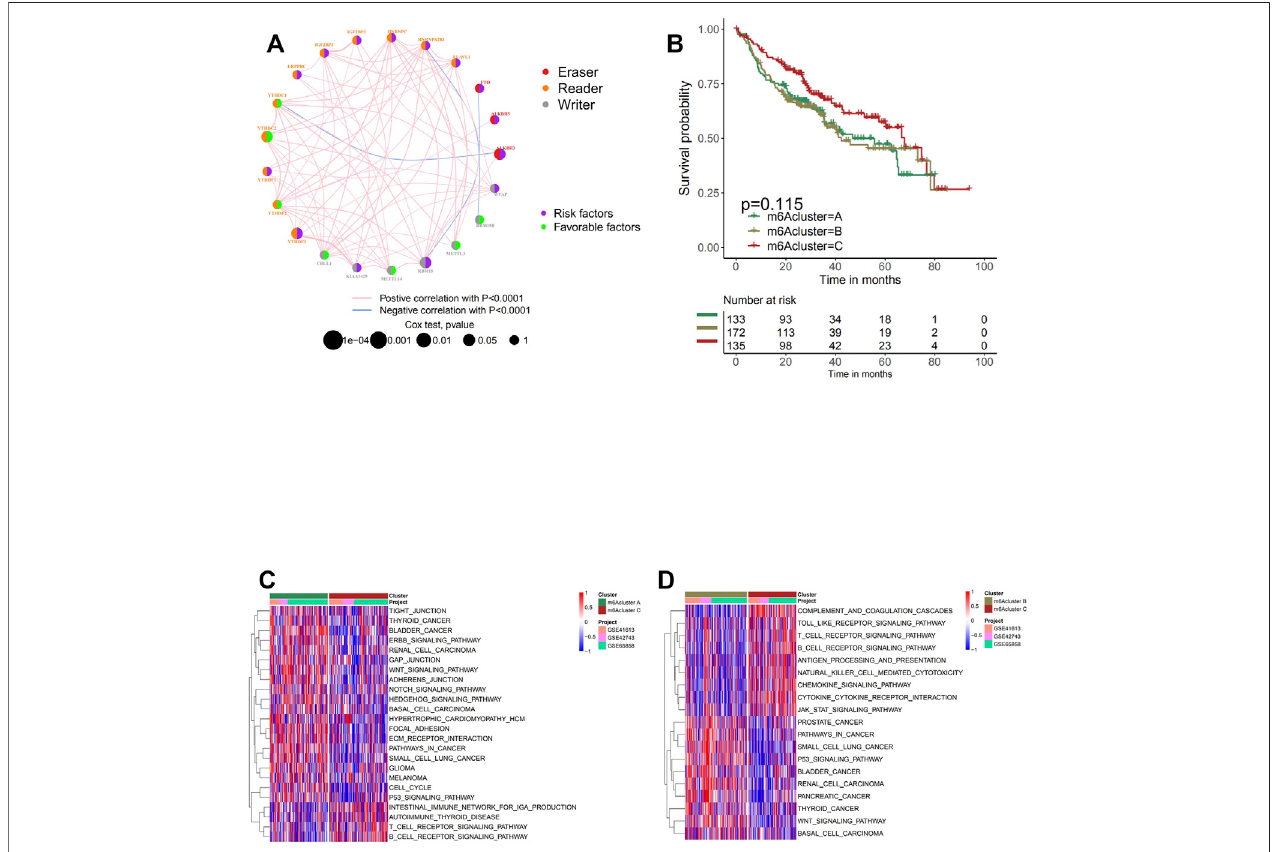
FIGURE 2 | Patterns of m6A methylation modi fi cation and biological characteristics of each pattern. (A) The interaction between m6A regulators in head and neck cancer.Thecirclesizerepresentstheeffectofeachregulatorontheprognosis,andtherangeofvaluescalculatedbylog-ranktestwas p < 0.001, p < 0.01, p < 0.05,and p < 0.1. Purple inthe right part ofthe circle, risk factors ofprognosis; green inthe right part ofthe circle, protective factors ofprognosis. Thelines linking regulators show their interactions, and thickness shows the correlation strength between regulators. The color in the right part of the circle represents whether the regulator is “ eraser ” (red), “ reader ” (orange), or “ writer ” (gray). Negative correlation is marked in blue, and positive correlation with red. (B) Survival analyses for the three m6A modi fi cation patterns based on 440 patients with head and neck cancer from four cohorts (GSE41613, GSE42743, GSE65858, and GSE65858PFS) including 133 cases in m6A cluster A, 172 cases in m6A cluster B, and 135 cases in m6A cluster C. Kaplan – Meier curves with log-rank p -value 0.115 show a signi fi cant survival difference among three m6A modi fi cation patterns. m6A cluster C shows signi fi cantly better overall survival than the other two m6A cluster. (C, D) Gene Set Variation Analysis (GSVA) enrichment analysis shows the activation states of biological pathways in distinct m6A modi fi cation patterns. The heatmap was used to visualize these biologicalprocesses;andredrepresentsactivatedpathways,andbluerepresentsinhibitedpathways.Theheadandneckcohortswereusedassampleannotations. (C) m6A cluster A vs. m6A cluster C; (D) m6A cluster B vs. m6A cluster C.